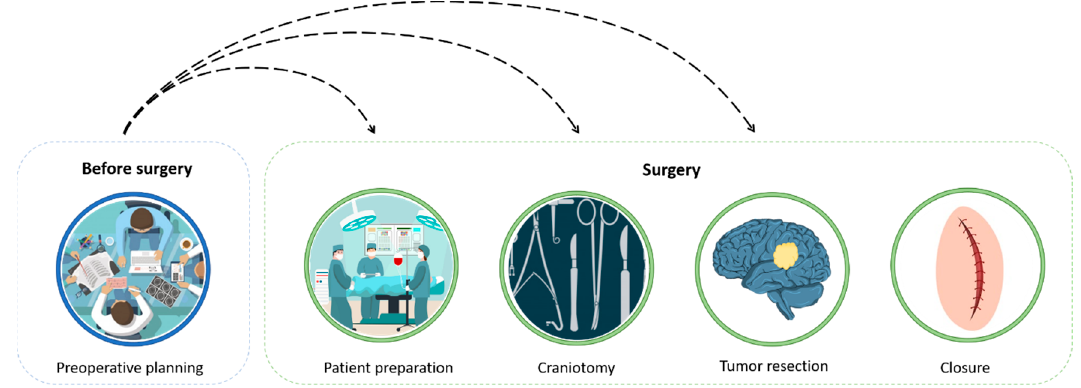
Figure 1. Brain surgery schematic pipeline. Preoperative planning drives the entire procedure.